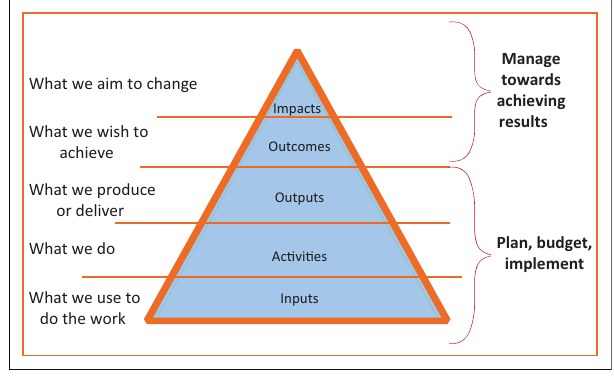
FIGURE 2: The logframe model.